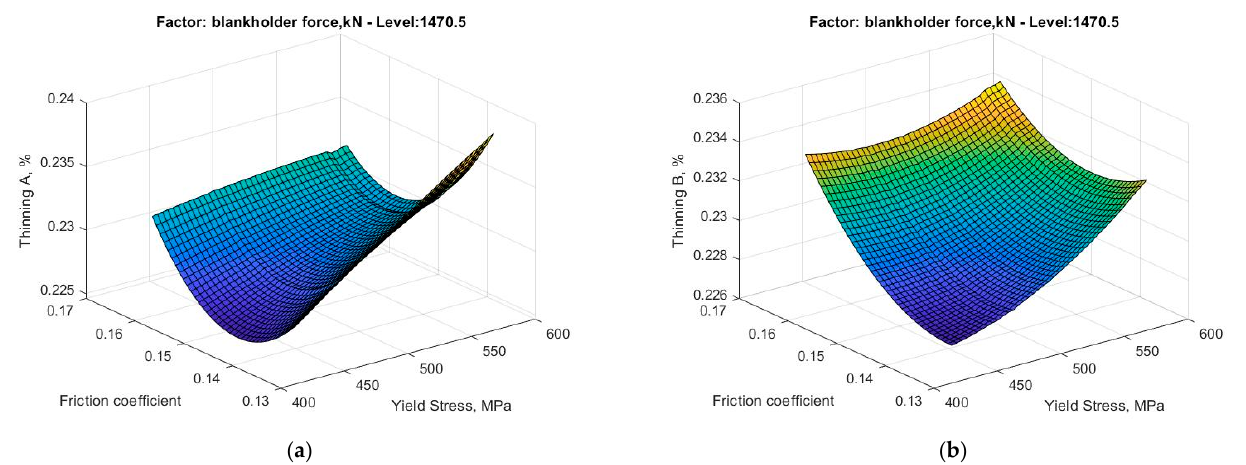
Figure 13. ( a ) Metamodel of the percentage of thinning at Critical Point A as friction coefficient and yield stress vary; and ( b ) metamodel of the percentage of thinning at Critical Point B as friction coefficient and yield stress vary.